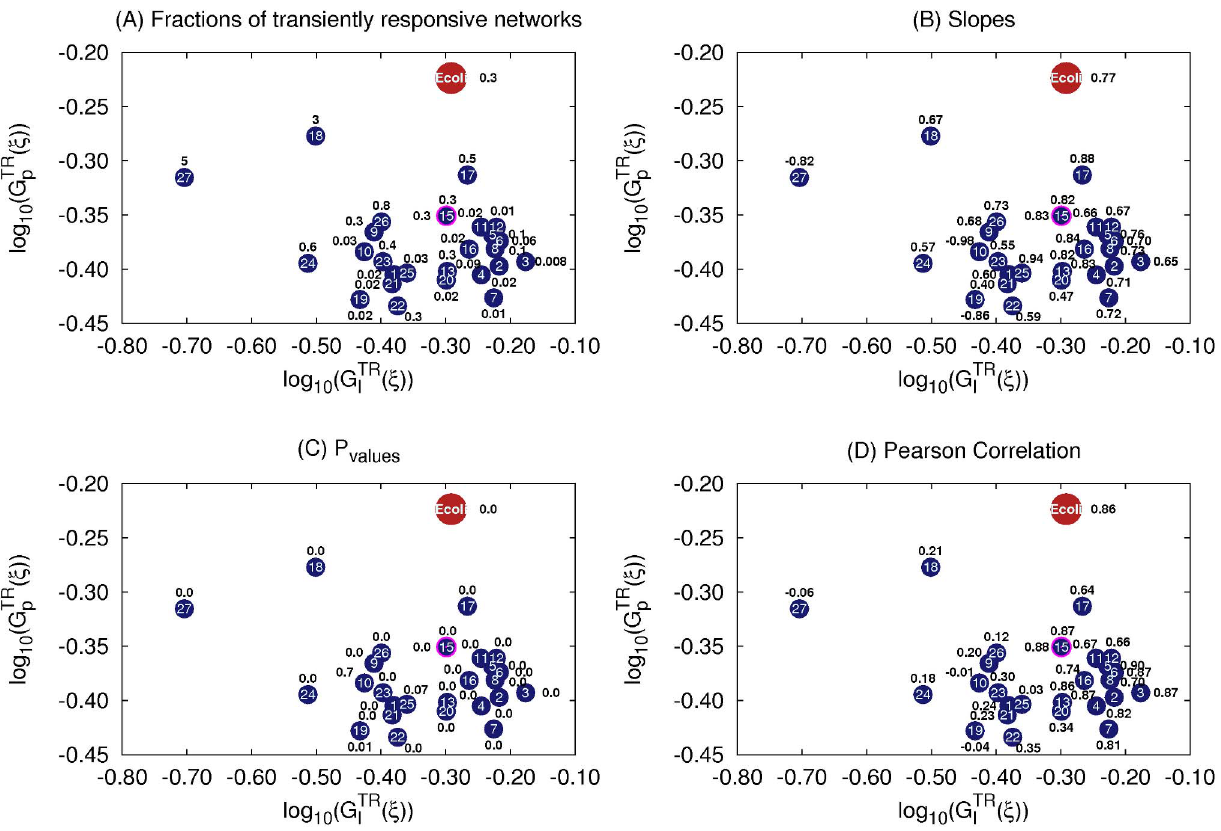
Figure 12. Chemotaxis networks responding to a change in a chemo-attractant. Each blue circle represents a topology responding to change in the concentration chemo-attractants in the environment. The index of each topology is given inside the circle. The blue circle highlighted in red represent two topologies, 14 and 15, whose positions overlap. The corresponding values of the fraction of TR networks (A), slopes of the linear regression of their E I , E p values (B), p (C), and r (D) values of the regression are shown next to the blue circle.